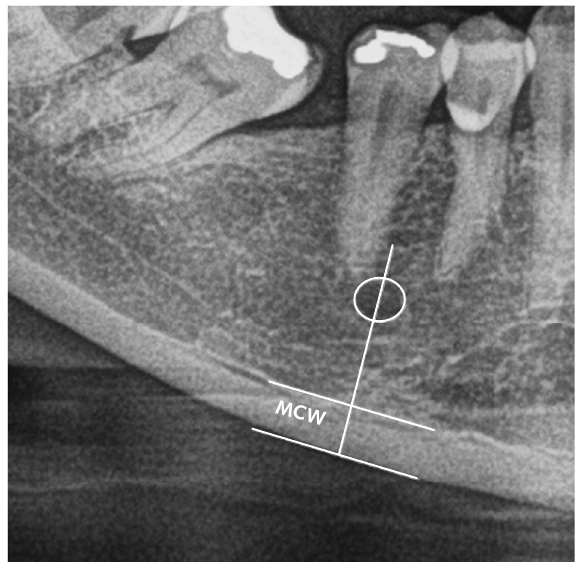
Figure 2. Vertical line measuring the mandibular cortical width (MCW) in the region of the mental foramen.